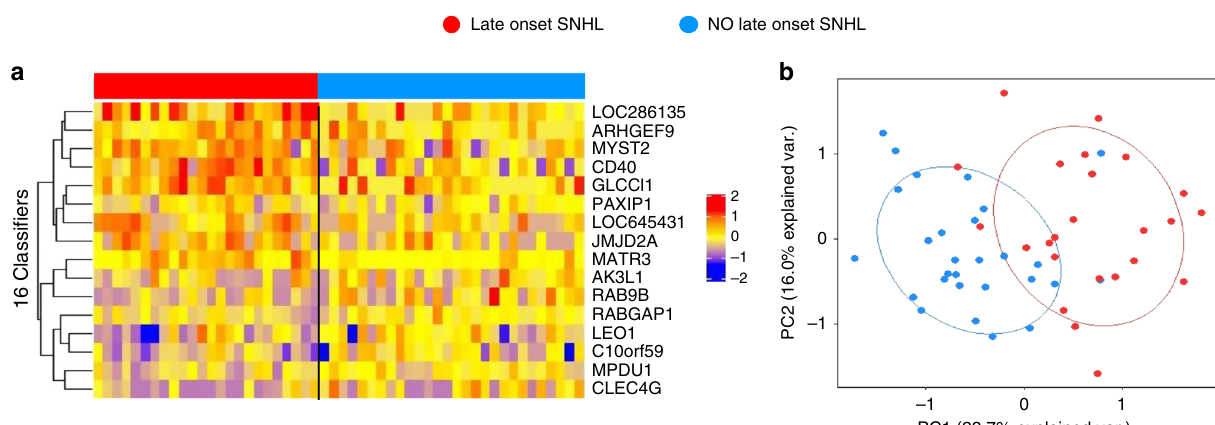
Fig. 7 Classi fi er genes for late-onset SNHL in infants with cCMV infection. Twenty-four infants with cCMV infection (11 asymptomatic and 13 symptomatic) developed SNHL during follow-up compared with 28 cCMV infants (12 asymptomatic and 16 symptomatic) that did not develop SNHL and had at least 900 days of follow-up. a Random Forest-Recursive Feature Elimination (RF-RFE) algorithm, identi fi ed a 16-gene signature that classi fi ed cCMV-infected infants who developed SNHL with 92% accuracy with samples obtained at baseline. The 16-gene list signature is displayed in a heat map format where each column represents the pro fi le of an infant and each row one of the 16 transcripts. Red indicates overexpression and blue transcript underexpression. b The 16 classi fi er gene set was validated by principal component analyses (PCA) that showed two clusters of cCMV infants according to the development of late-onset